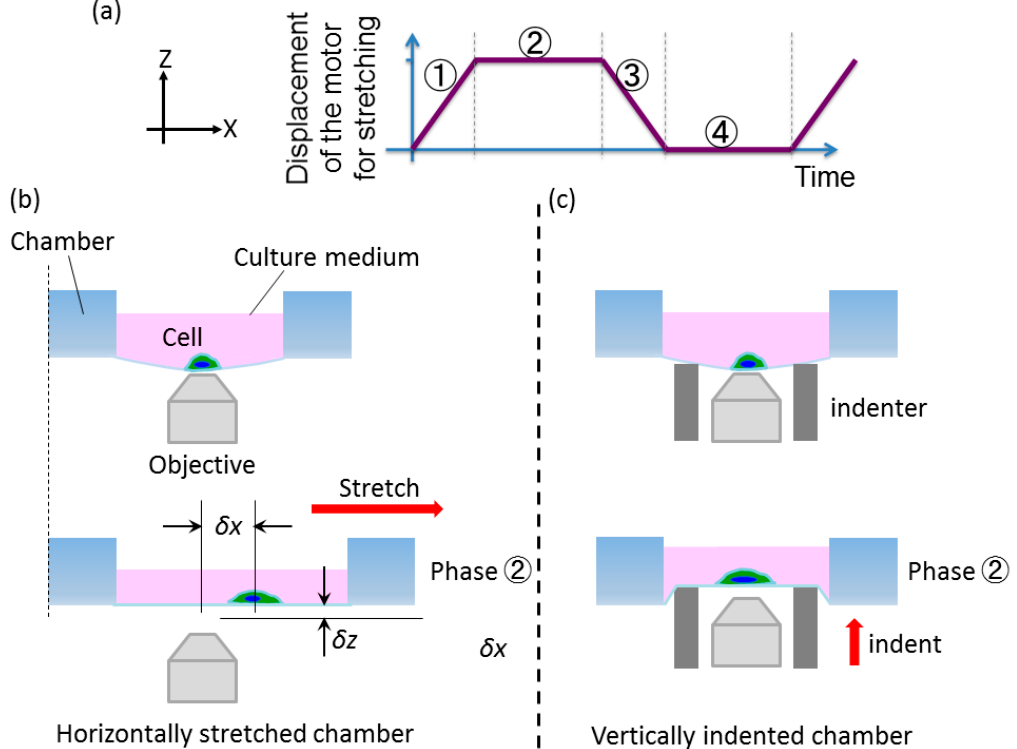
Figure 1. Problems on conventional cell stretching chambers for cell imaging. ( a ) A diagrammatic sketch of the trapezoidal waveform used for the control of the chamber stretching motor in this study. ( b ) The chamber is typically made of Dimethylpolysiloxane (PDMS) which is an elastic and transparent material. An actuator is used to deform the chamber in the horizontal direction. It is difficult to continuously observe the target cells with the high magnification of a microscope during stretching. Because, under the stretching motion, the position of the cell is moved from the field of view of the microscope. ( c ) A stretching method for cell imaging applied by Huang et al. [39]. Vertical displacement of the indenter stretches the membrane, which results in a displacement in the z -direction. Therefore, researchers have to stop the system and adjust the focus to get live cell images.